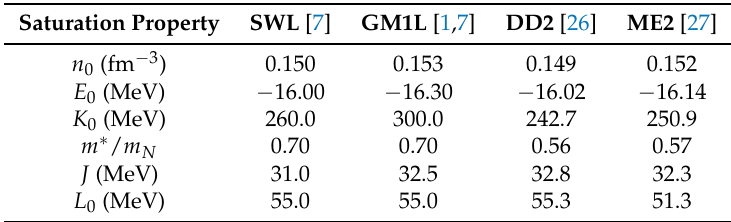
Table 1. Properties of symmetric nuclear matter at saturation density for the hadronic parametrizations of this